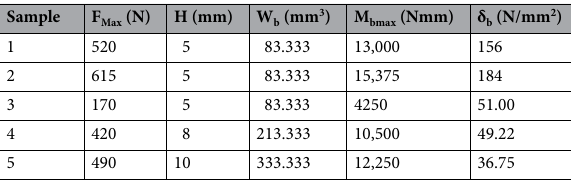
Table 4. Bending test results.